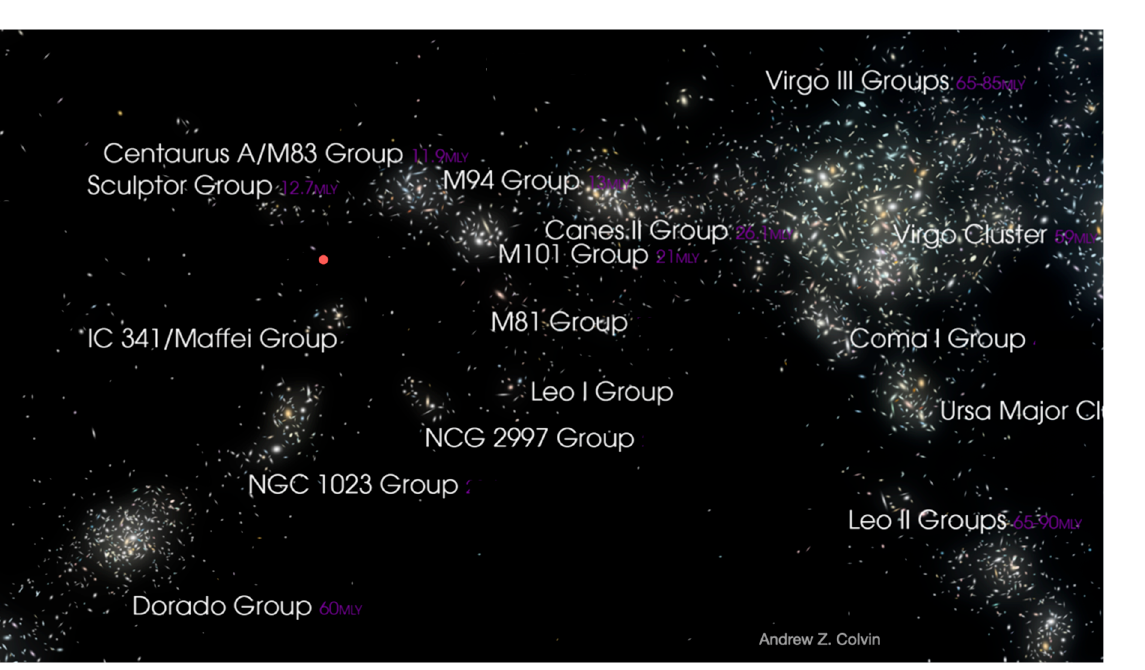
Figure 2. Galaxy clusters and groups comprising the Laniakea supercluster. The small red dot slightly above and left of center shows the position of the Local Group of galaxies of which the Milky Way galaxy is a member. Image credit: Andrew Z. Colvin, Creative Commons Attribution.